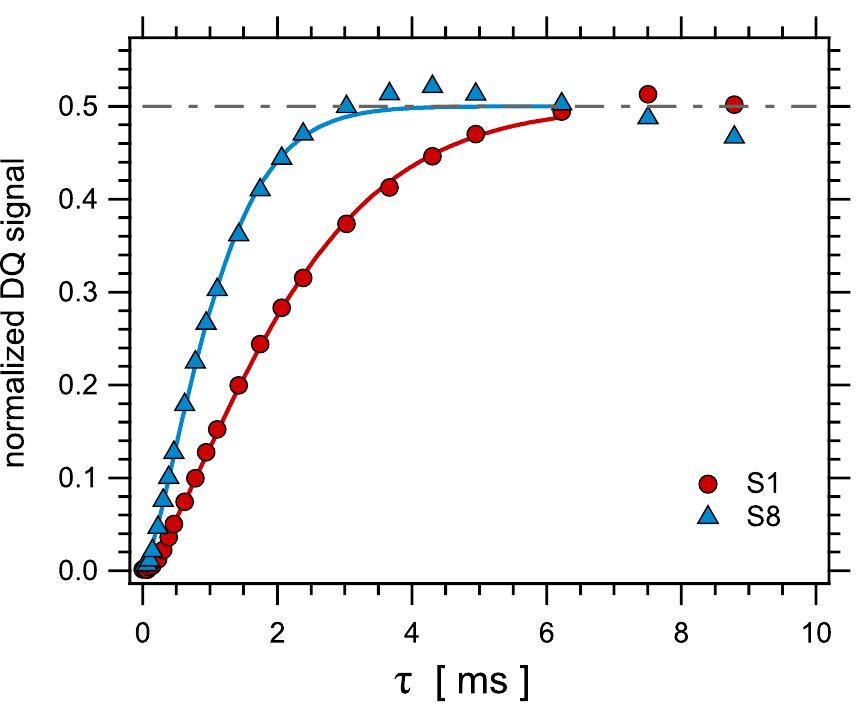
Figure 2. Representative normalized DQ curves obtained in samples S1 and S8. Symbols are experimental data, curves are fits with Equation